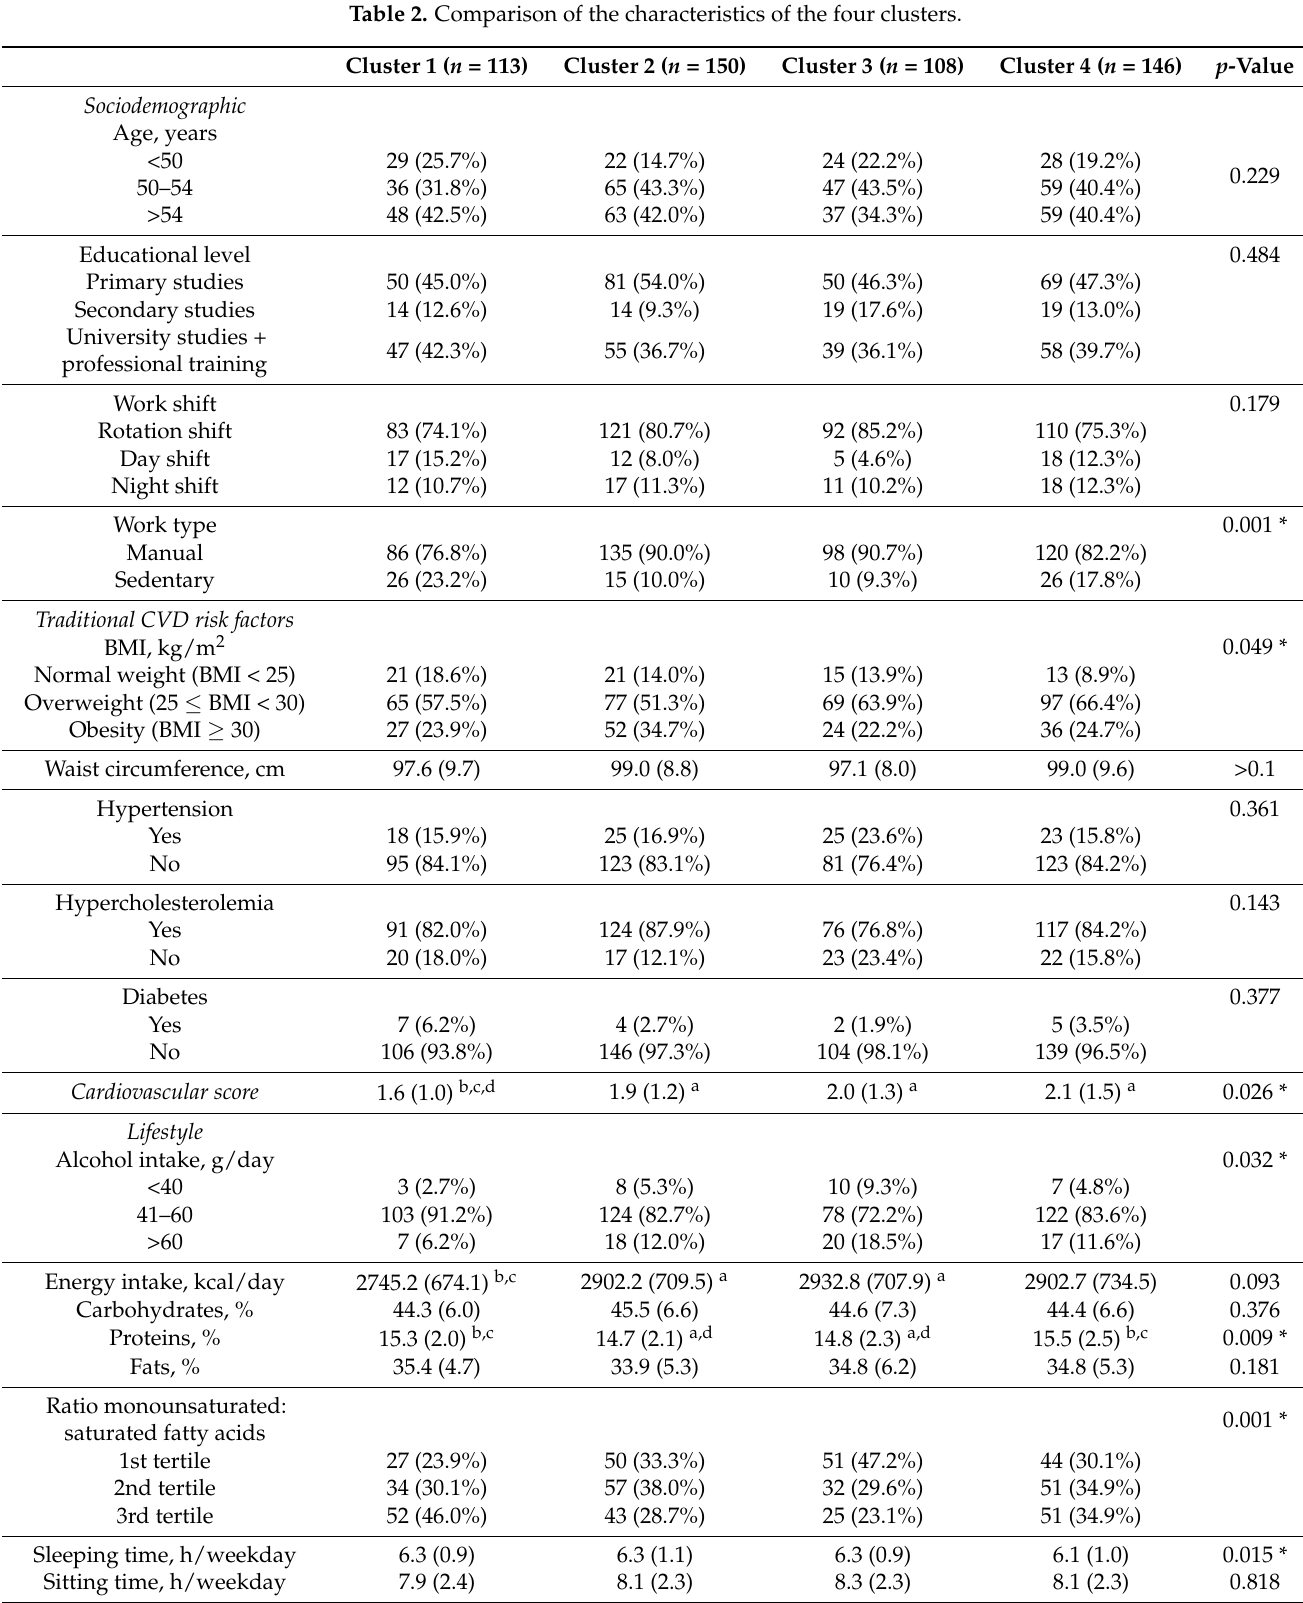
Table 2. Comparison of the characteristics of the four